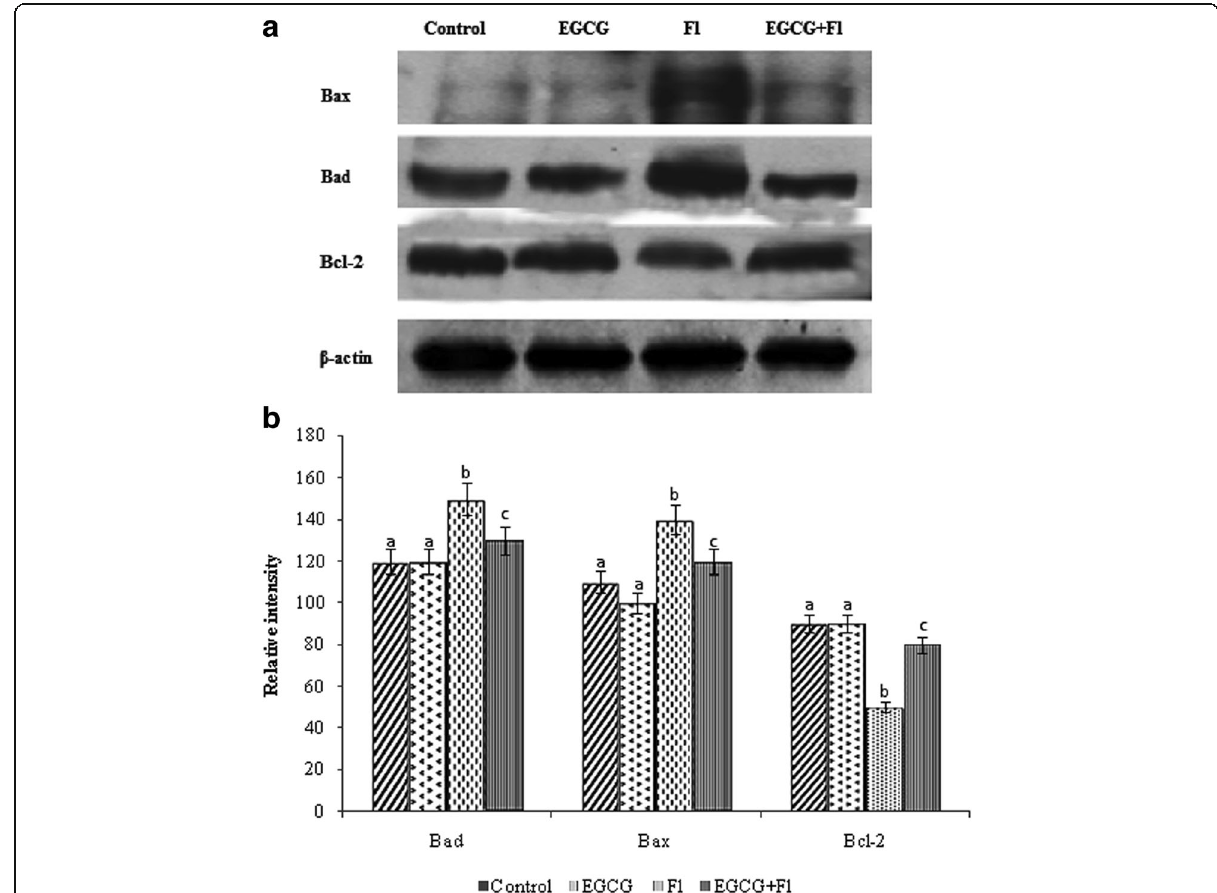
Fig. 7 a Effect of EGCG on Bad, Bax, and Bcl2 protein band intensity through western blot analysis in the hippocampus of control and experimental rats. b The densitometric analysis of protein expression of Bad, Bax and Bcl2 of hippocampus of control and experimental rats. Values are mean ±SD for six rats in each group. a, b and c Values are not sharing a common superscript letter (a, b and c) differ significantly at p < 0.05